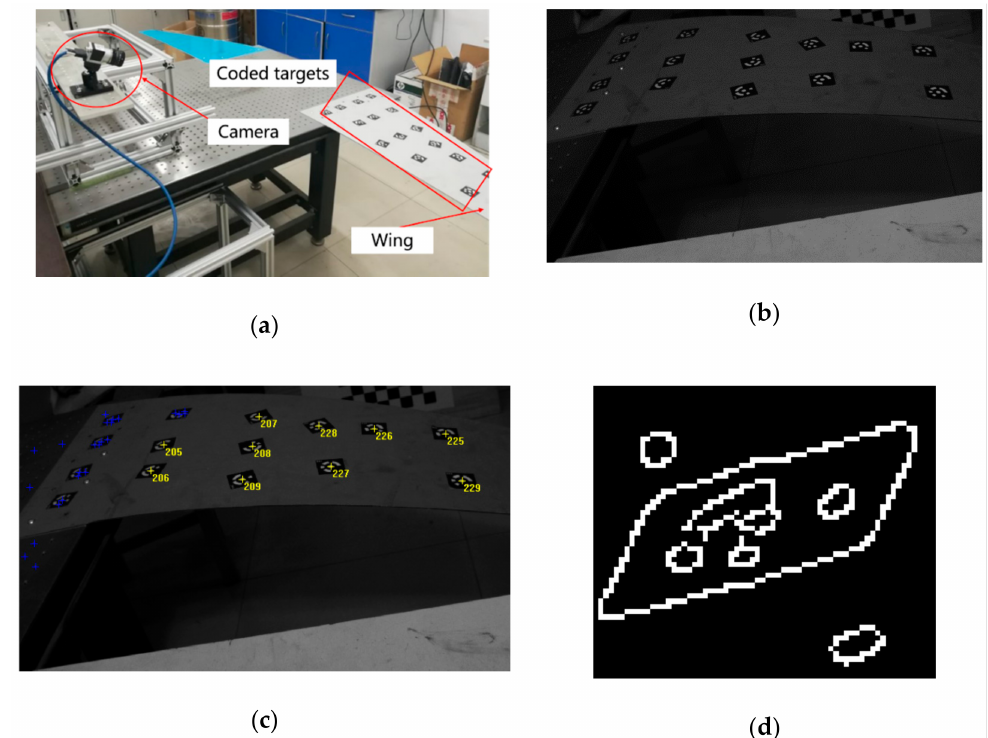
Figure 4. The experiment to verify the performance of Schneider’s design: ( a ) Experimental setup; ( b ) The real image has been taken with underexposure and heavily dark background; ( c ) The result of identifying the coded targets using commercial software; ( d ) The canny edge detection result of the coded target in the upper left